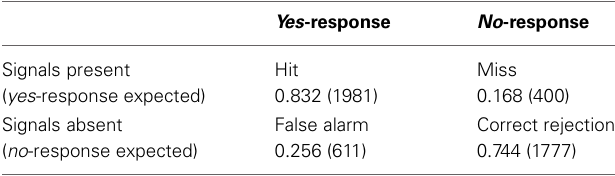
presence of the two signals being at bar and Looking at